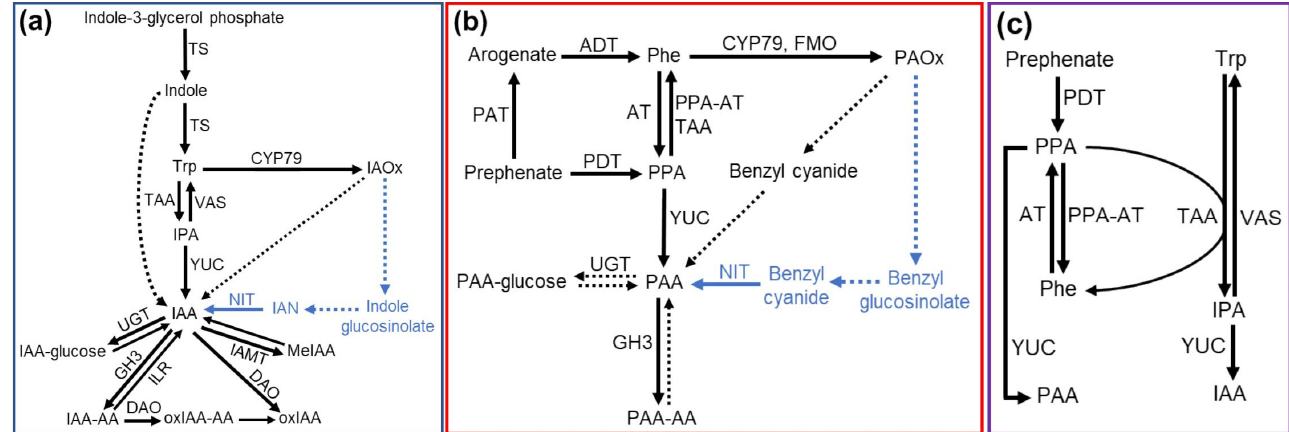
Figure 1. Schematic diagrams of IAA biosynthesis: ( a ) PAA biosynthesis, ( b ) and a link between IAA and PAA homeostasis in plants ( c ). The pathways only include steps and enzymes that are demonstrated via genetic evidence. Solid arrows represent single reactions catalyzed by known enzymes, and dotted arrows represent predicted single or multiple steps. Blue arrows and metabolites represent pathways and metabolites present only in Brassicales species. IAA, indole-3-acetic acid; IAA-AA, amino acid-conjugated IAA; IAN, indole-3-acetonitrile; IAOx, indole-3-acetaldoxime; IPA, indole-3-pyruvate; MeIAA, methyl-conjugated IAA; oxIAA, 2-oxindole-3-acetic acid; oxIAA-AA, amino acid-conjugated oxIAA; PAA, phenylacetic acid; PAA-AA, amino acid-conjugated PAA; PAOx, phenylacetaldoxime; Phe, phenylalanine; PPA, phenylpyruvate; Trp, tryptophan; AT, amino transferase; CYP79, cytochrome P450 mono-oxygenase of the 79 family; DAO, dioxygenase for auxin oxidation; FMO, flavin-containing mono-oxygenase; GH3, Gretchen Hagen 3 auxin-amido synthetase; ILR, IAA-Leu Resistant IAA-Amino hydrolase; IAMT, IAA carboxymethyltransferase; NIT, nitrilase; PAT, prephenate aminotransferase; PDT, prephenate dehydratase; PPA-AT, phenylpyruvate aminotransferase; TAA, tryptophan aminotransferase of Arabidopsis; TS, tryptophan synthase; UGT, UDP-glucuronosyltransferase; YUC, YUCCA family of flavin-containing mono-oxygenase; VAS; methionine aminotransferase.